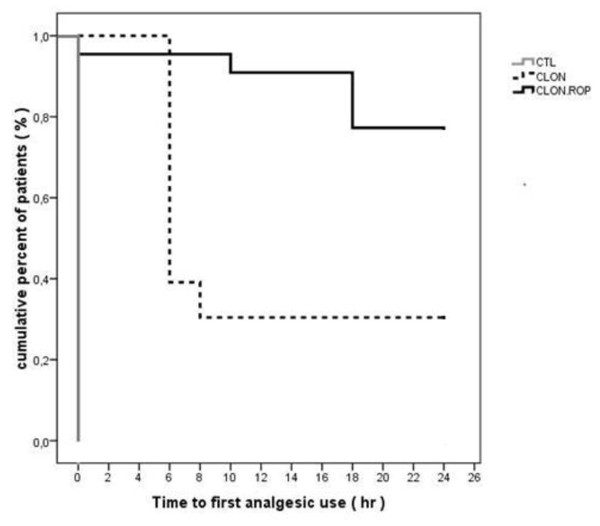
Kaplan-Meier analysis. Estimation of survival analysis of the time from the end of anesthesia to the first analgesic request in the Control, Clonidine and Clonidine plus 0.2% Ropivacaine groups.